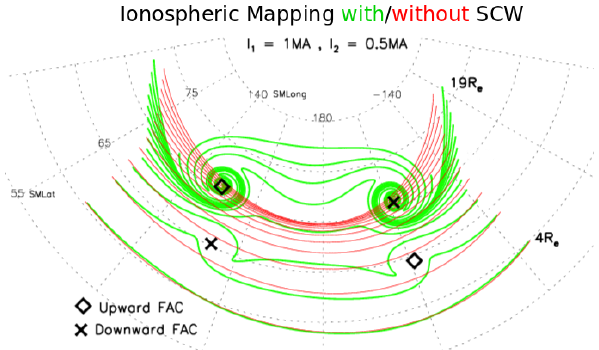
Figure 3. Ionospheric mapping of equatorial geocentric circle arcs (equatorial distance is labeled for selected circles). The red lines show neutral sheet mapping using the T89 + IGRF model; the green lines show mapping of the same points using the SCW2L + T89 + IGRF model. Ionospheric locations of upward (downward) FACs are indicated by diamond (cross) symbols. The SCW2L model is the same as in Fig.